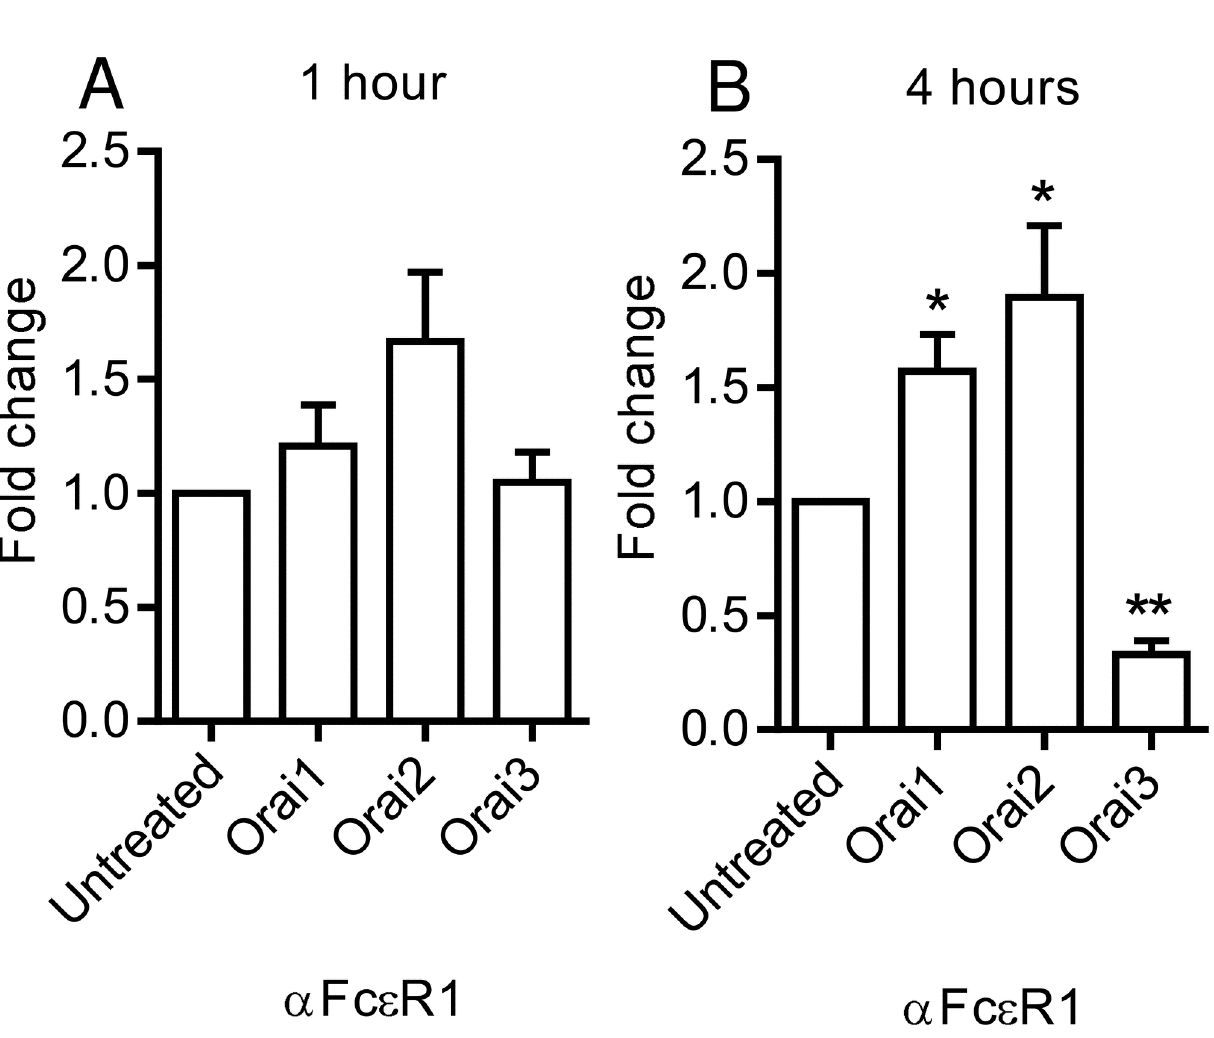
Figure 6. The effect of FcεRI-dependent HLMC activation on levels of Orai transcripts. Cells were activated with αFcεR1 antibody and the levels of Orai1-3 transcripts determined by quantitative RT-PCR ( A ) after activation for 1 hour and ( B ) for 4 hours. Mean ± SEM fold change compared to untreated cells. n=5, * p<0.05, ns not significant. Activation of HLMC for 4 hours results in the down-regulation of Orai3 and up-regulation of Orai1 and -2